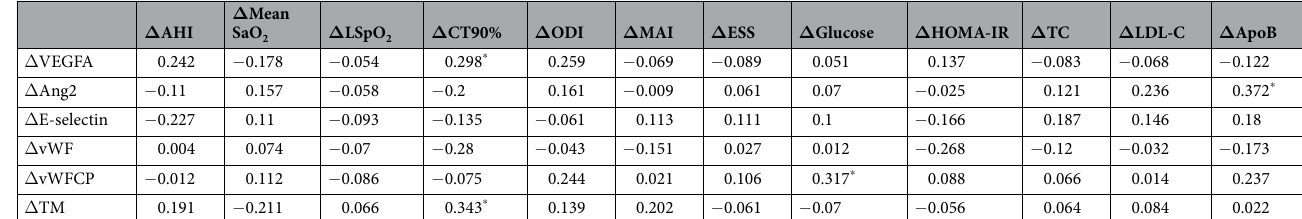
Table 5. Spearman’s correlations between changes in serum levels of 10 markers, PSG parameters